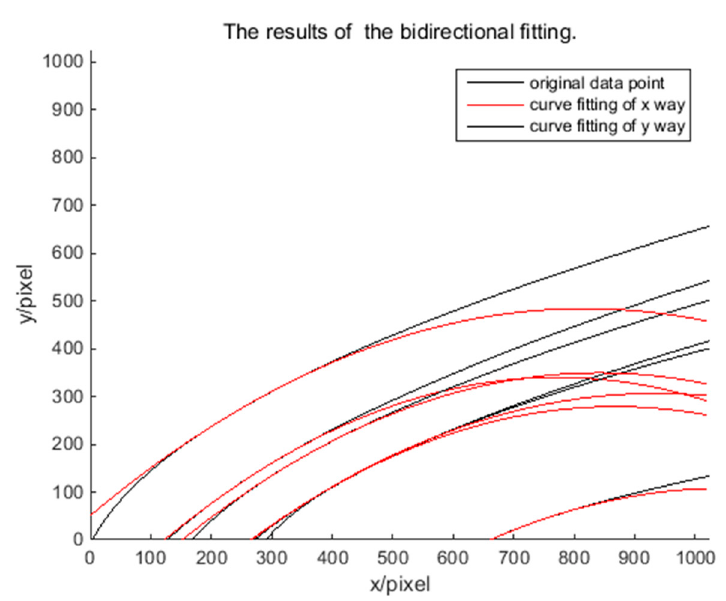
Figure 7. The results of the bidirectional fitting.